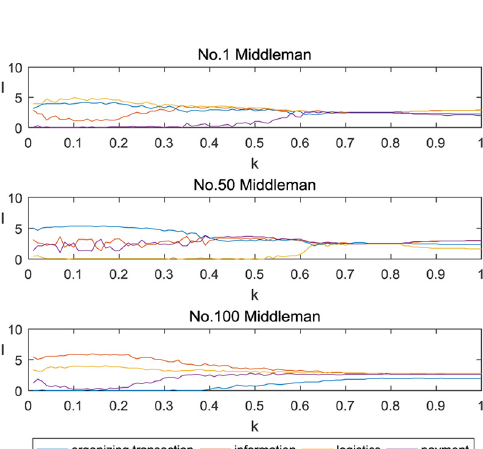
Figure 6. Price gradient h = 1